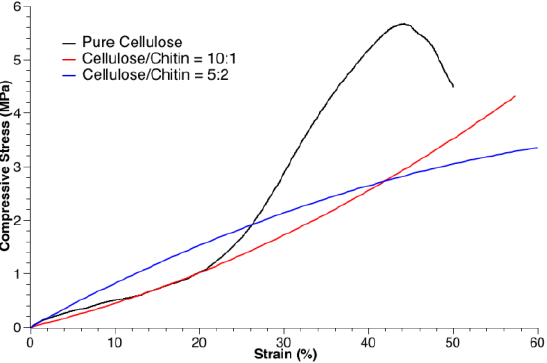
Figure 6. Compressive stress–strain curves for the 3D-printed products of pure cellulose (black), cellulose/chitin = 10:1 (red), and cellulose/chitin = 5:2 (blue).